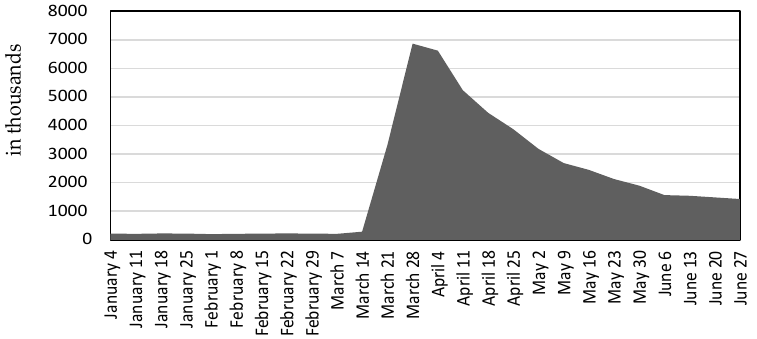
Figure 2. Number of initial unemployment insurance claims made per week in the United States from January to June 2020 (in 1000 s). The source of the figure is based on [14]. Before the e ff ects of the lockdown became apparent, weekly unemployment insurance claims exceeded 7 mln [14].